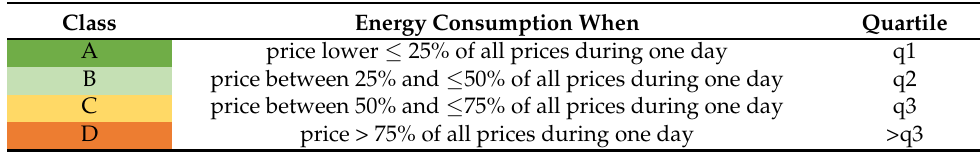
Table 5. Flexibility classification based on daily price